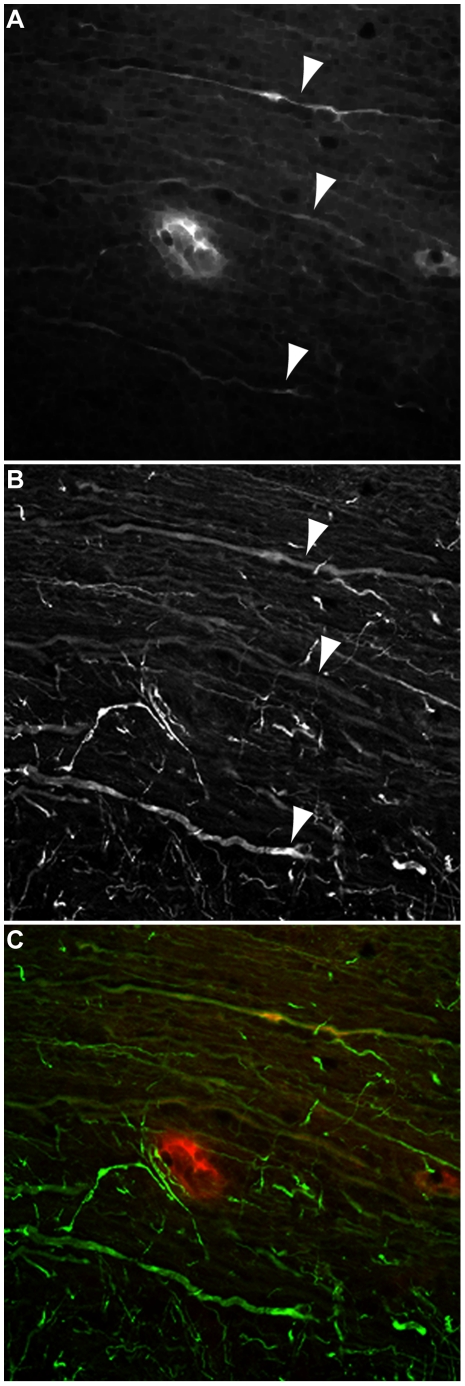
MHC class I is expressed on axons in demyelinated lesions.MHC class I expression colocalizes with dysmorphic axons immunostained for neurofilament. (A, C) MHC class I expression was observed in the 90 dpi spinal cord on fiber-like structures (red channel in C). (B, C) These same structures expressed neurofilaments and exhibited a dysmorphic pattern consistent with injured axons (green channel in C). Arrowheads point to the same structures in (A) and (B).